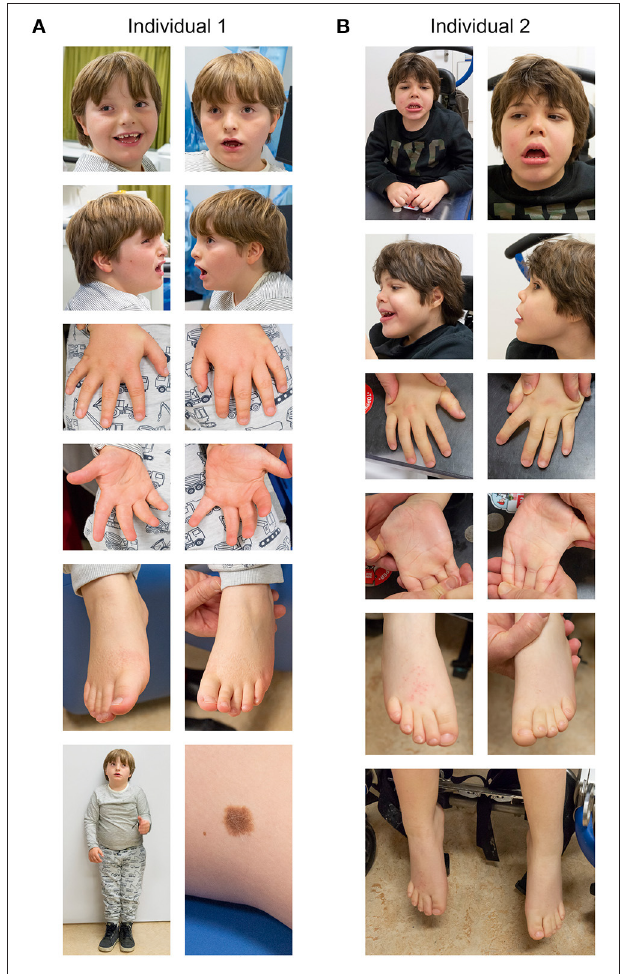
FIGURE 1 | Clinical photographs of individual 1 (A) and individual 2 (B) . See text for